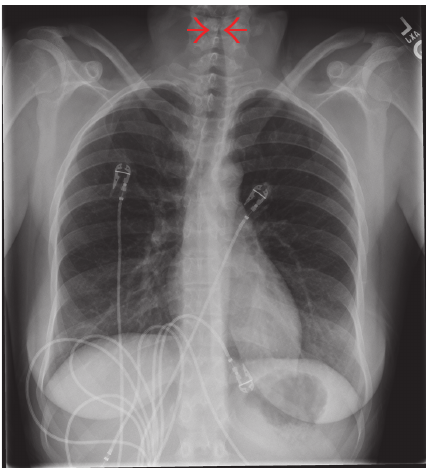
Figure 1: Hospital day 0 posterior-anterior chest radiograph demonstrating subglottic stenosis, known as Steeple sign (between red arrows).